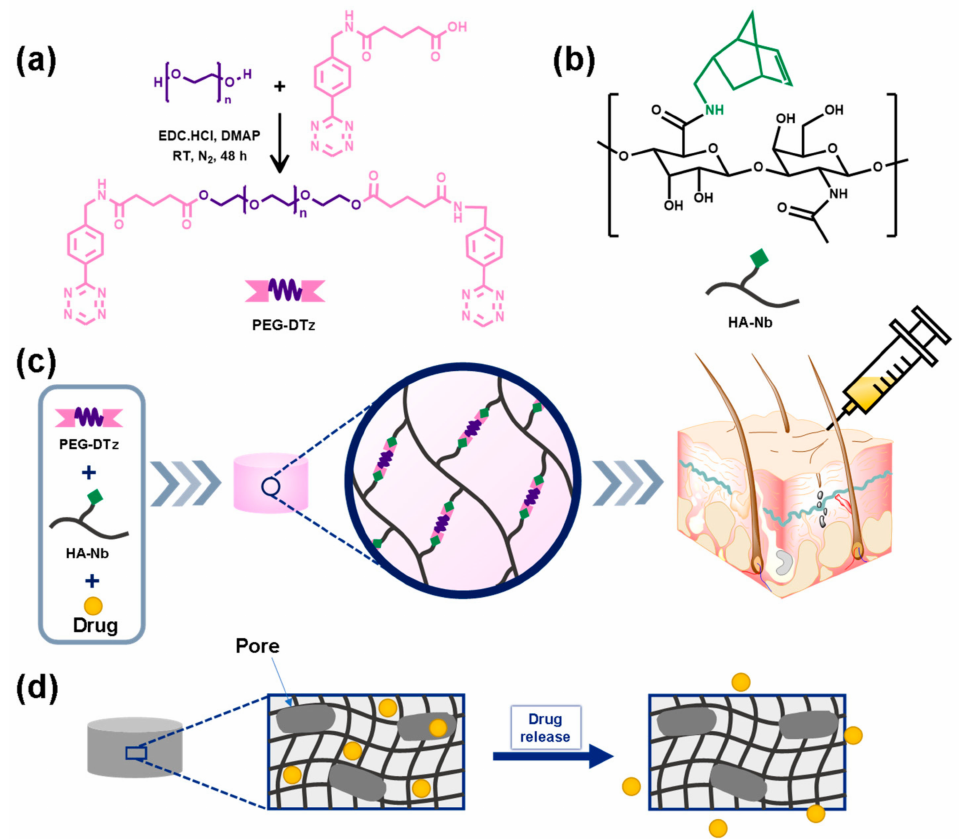
( c ) Schematic diagram representing development of injectable hydrogels, and ( d ) Mechanism of curcumin release from the porous